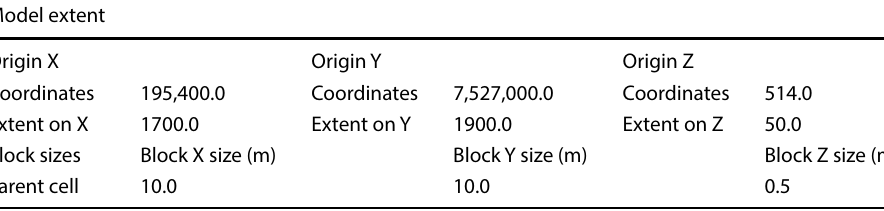
Table 2 Limits of the block model of the Musina Copper Mine tailings dump